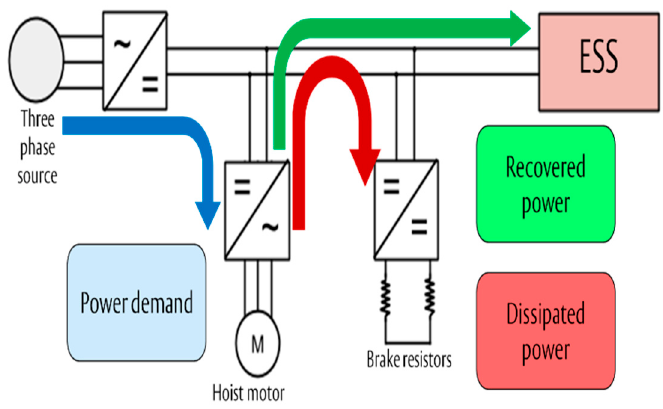
Figure 2. The consumed, dissipated and recovered power flow directions at an RTG system with ESS.